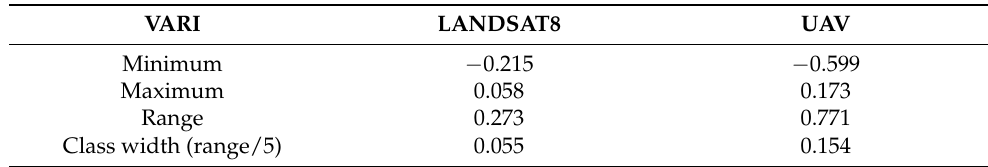
Figure 4. Examples of satellite ( a ) and drone ( b ) images caught in Serra de Los Donceles forest (Castilla-La Mancha, Spain). Table 2. Calculation of the class width for the VARI classification in ranks in Sierra de Los Donceles forest (Castilla-La Mancha, Spain) (Source: our